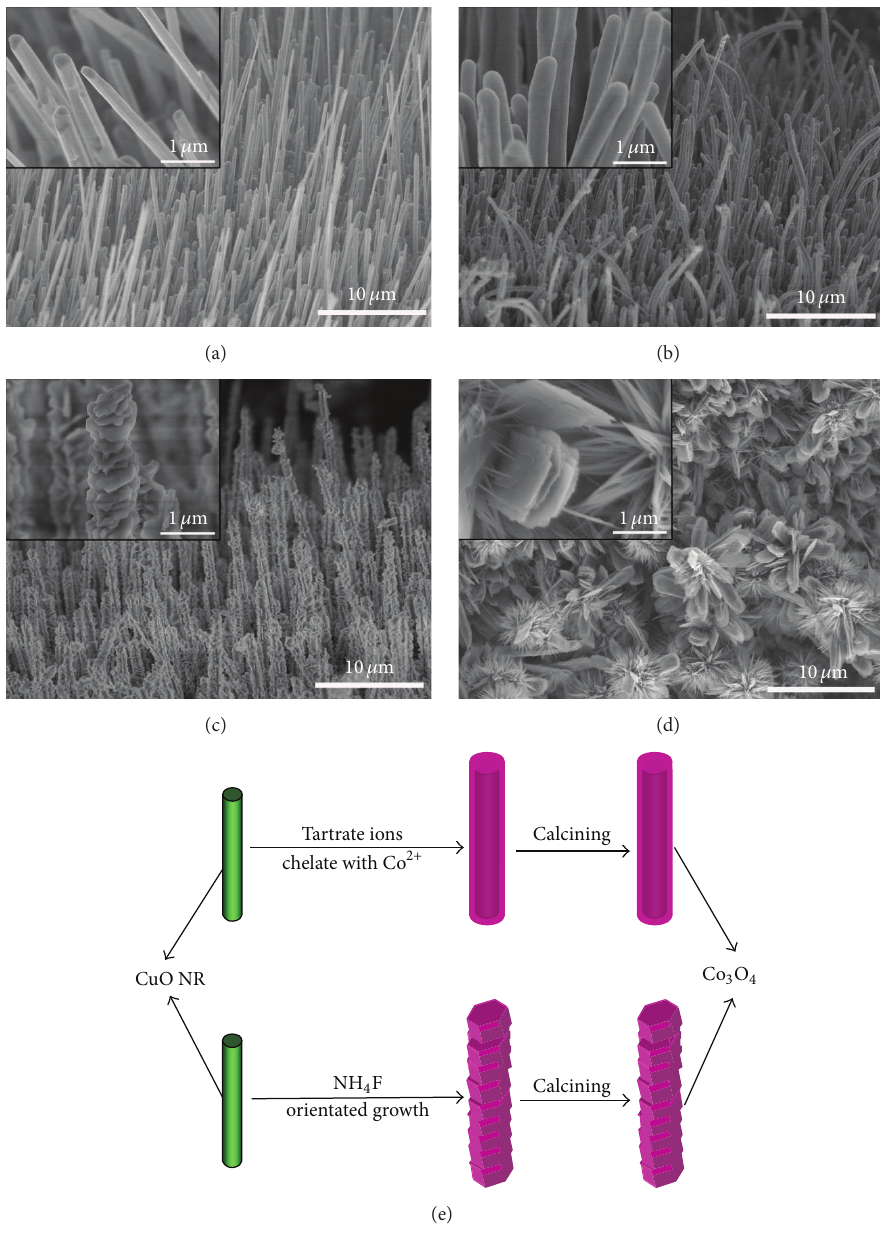
Figure 2: SEM images of (a) CuO NR arrays and different morphology of CuO/Co 3 O 4 composite, (b) CuO/Co 3 O 4 coaxial heterostructures, (c) CuO/Co 3 O 4 nanosheets, and (d) Co 3 O 4 nanoflowers. The insets show the high-magnification images of the corresponding samples. (e) Schematic diagram of the growth mechanism of the CuO/Co 3 O 4 composite